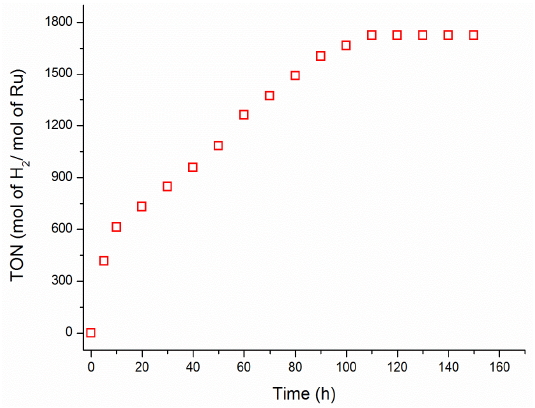
Figure 5. Plot of turnover number versus time for the dehydrogenation of dimethylamine borane (3000 mM) catalyzed by Ru(acac) 3 (5.0 mM) pre-catalyst along with [Ru(N 2 Me 4 ) 3 (acac)H] in toluene at 60.0 ± 0.1